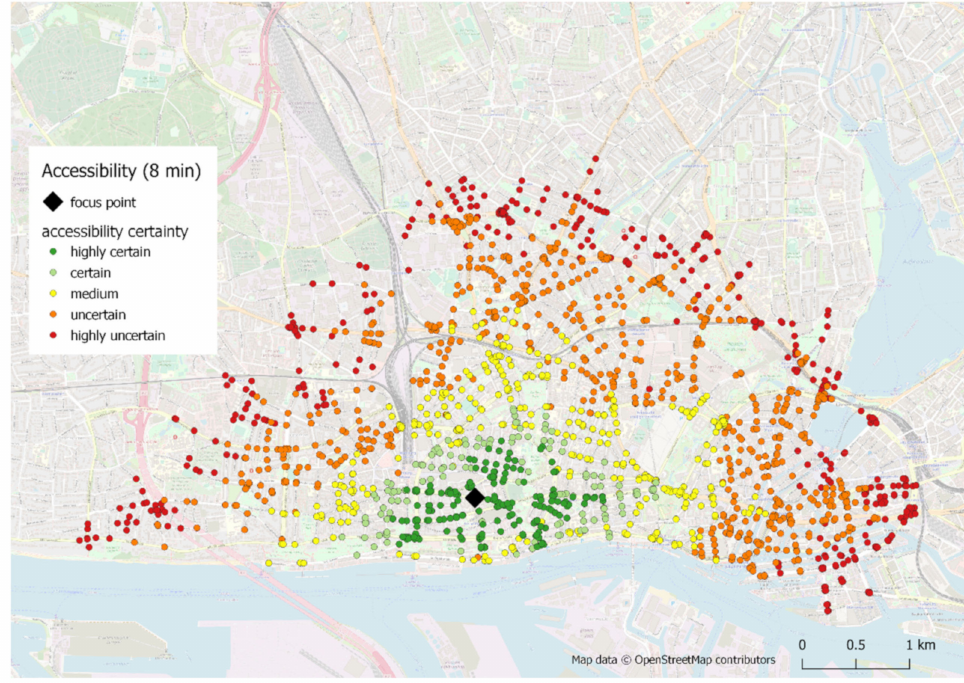
Figure 7. Example 3: Spatial variance around eight minutes’ isochrones, expressed by network isochrone